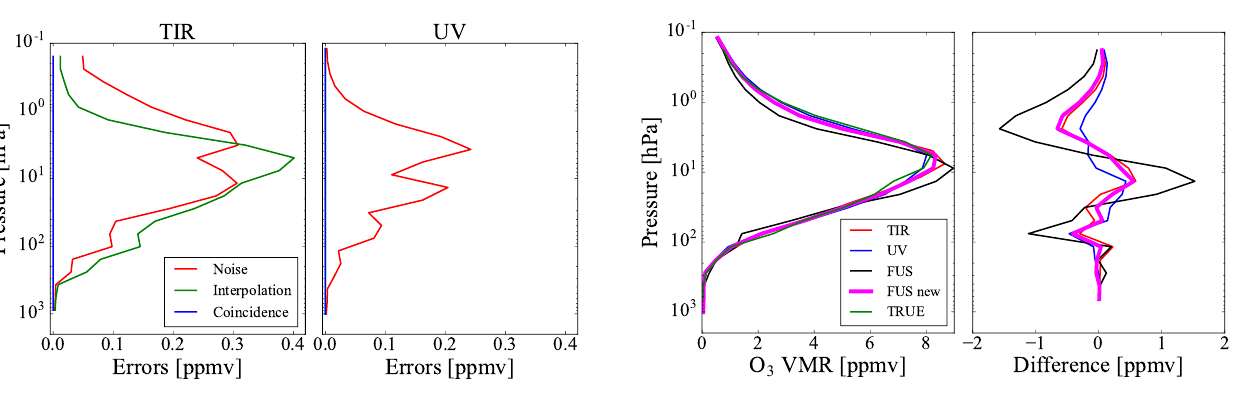
Figure 6. The fused profile and the residual error obtained with the modified algorithm (magenta lines) compared with the same quan- tities of Fig. 2b and c.